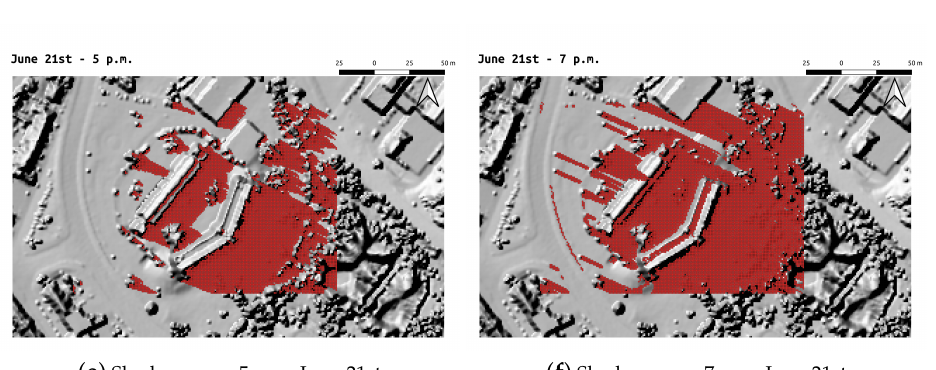
Figure 12. Shadow map for 21 June 2020 from 9 a.m. to 7 p.m. 2 h